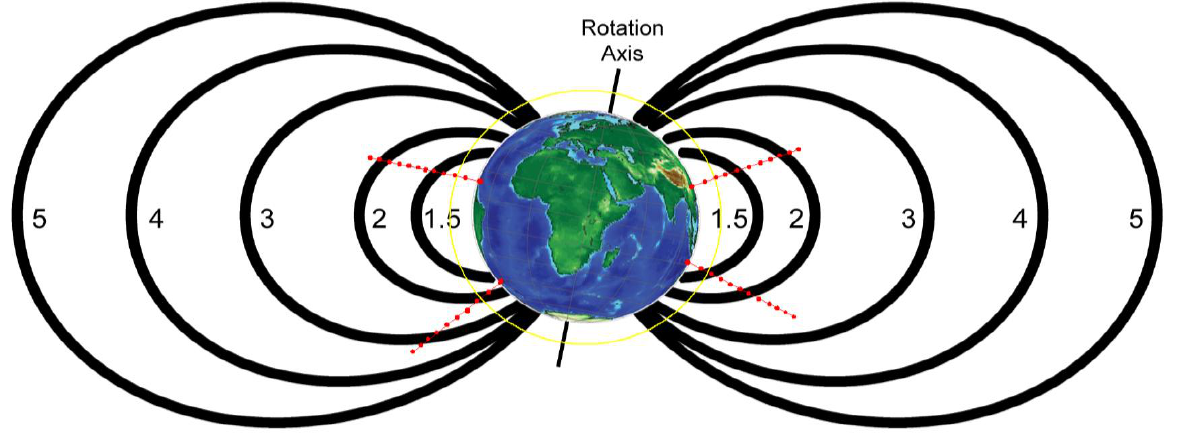
Figure 5. A sketch representing the satellite orbit (yellow) and earthquake epicenter projections (red) with respect to the L-shells. We can see that the satellite passes through high L-shells at the poles, while EQ epicenters projections cover only low L-shell values as the EQ epicenters at high latitudes are